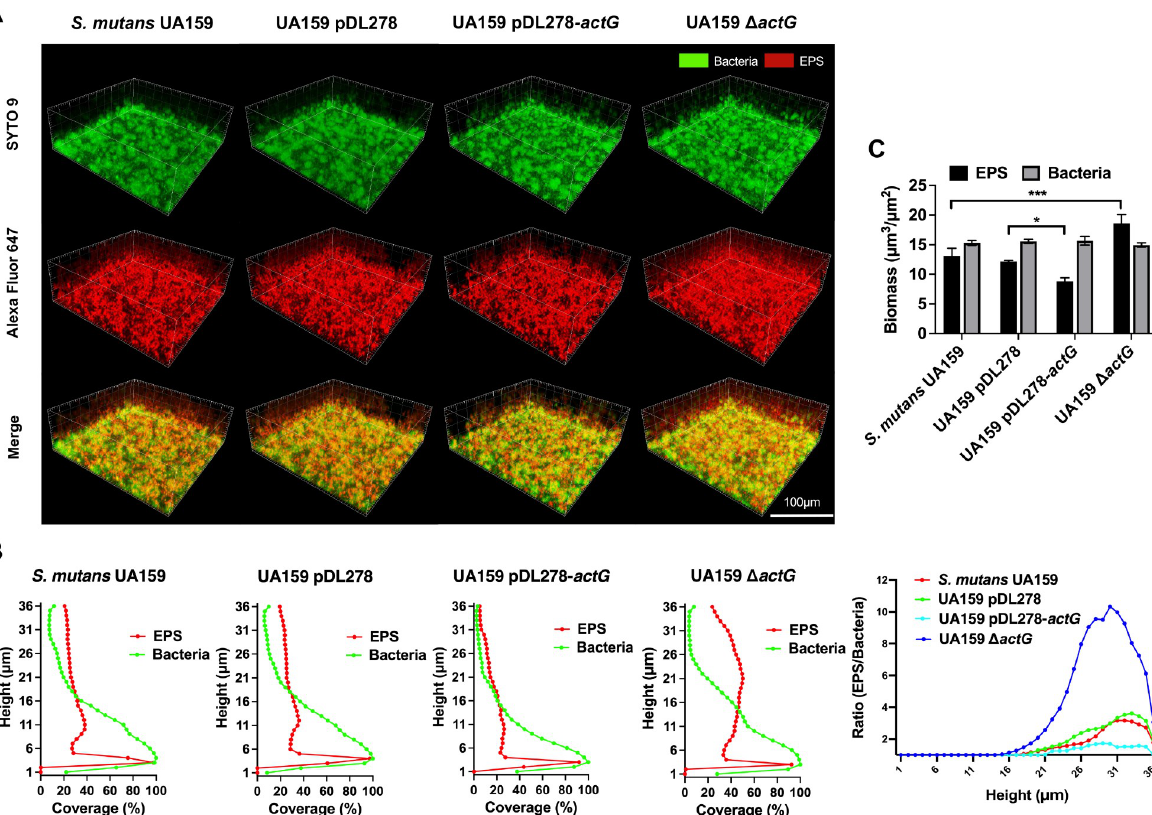
Fig 3. Effect of actG on biofilm structure and composition of S . mutans . Confocal laser scanning microscopy (CLSM) analysis of the three- dimensional visualization of bacteria (green) and EPS (red) of 24-hours biofilms. Images were captured at 60 × magnification, and the three- dimensional reconstructions of biofilms were performed with IMARIS 7.0.0 (A). Quantitative analysis of bacteria and EPS biomass and the ratio of EPS to bacteria was performed with COMSTAT (B, C). Representative images are shown from at least 5 randomly selected positions of each sample. Results are presented as mean ± SD ( � P < 0.05 or ��� P <